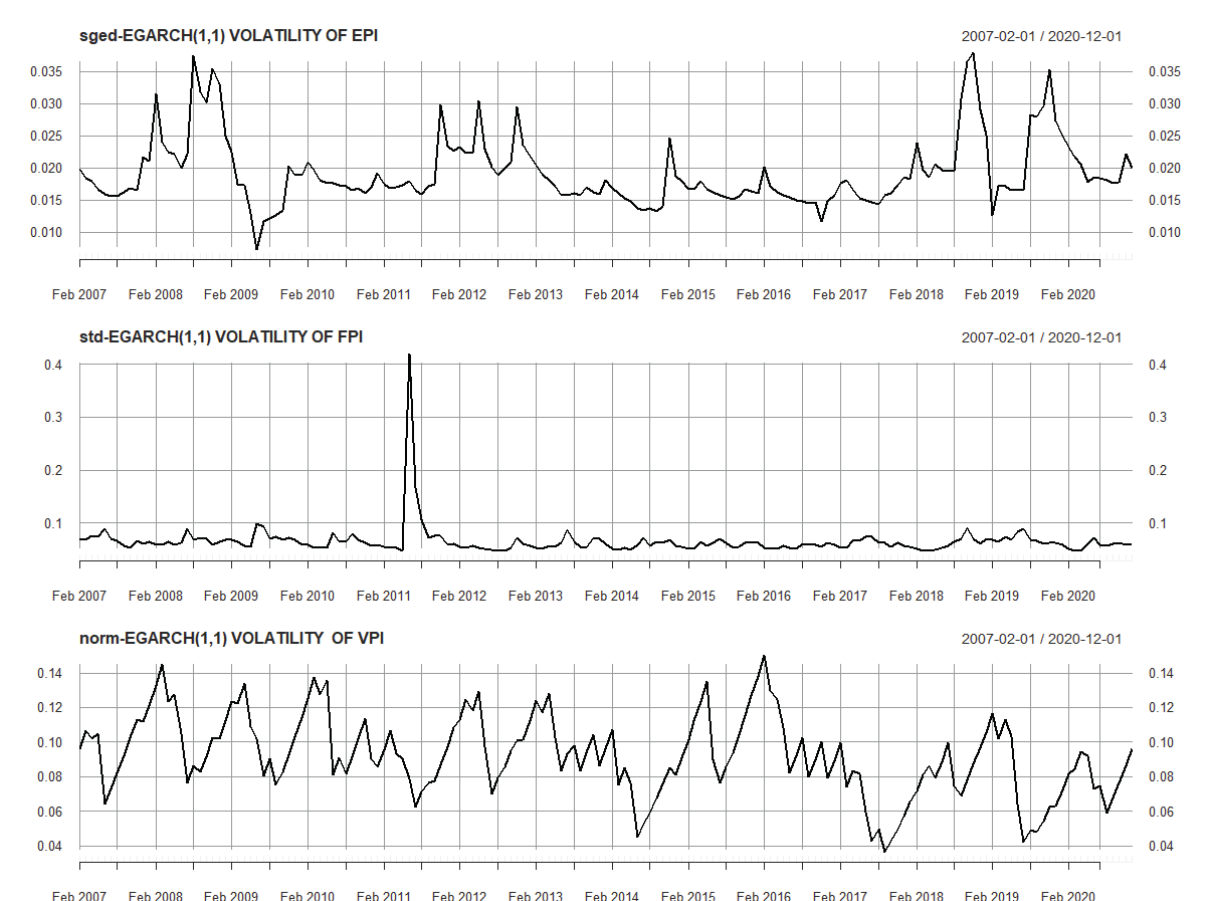
Figure 2. Time-Series Plot of Volatilities Obtained from EGARCH